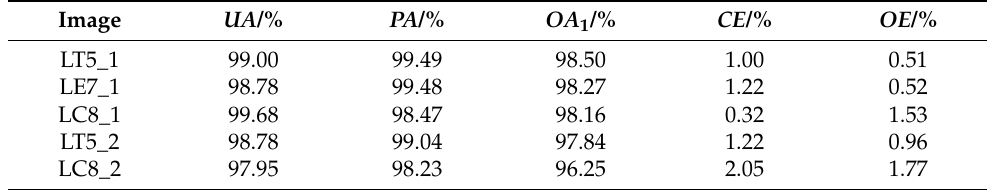
Figure 11. Extraction results with OOBR: ( a – c ) are the results of Landsat TM, ETM+ and OLI images, respectively, in study area 1; ( d , e ) are the results of Landsat TM and OLI images, respectively, in study area 2. Table 3. Accuracy of the results with OOBR.